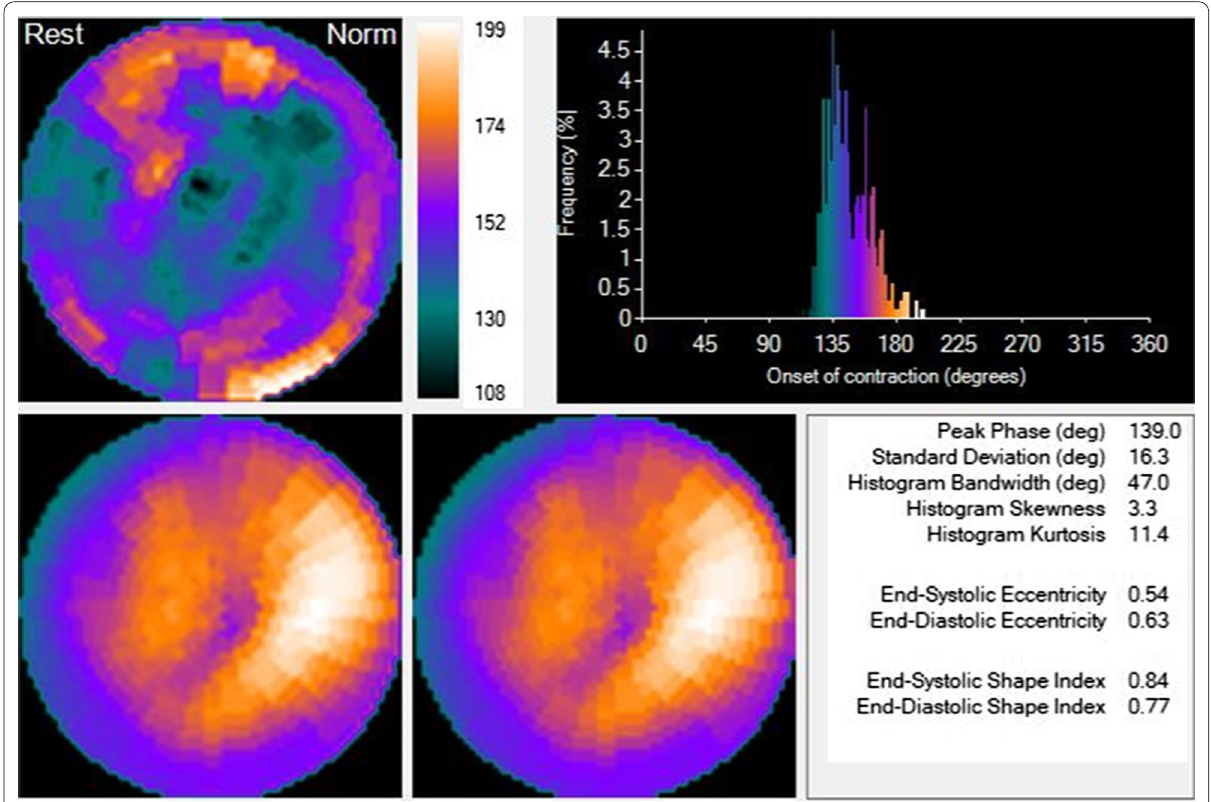
Fig. 4 Same patient, intraventricular synchronism behavior post-CRT. Compared to Fig. 3, it shows a significant reduction of dyssynchrony post-CRT. CRT cardiac resynchronization therapy, HBW histogram bandwidth, PSD phase histogram standard